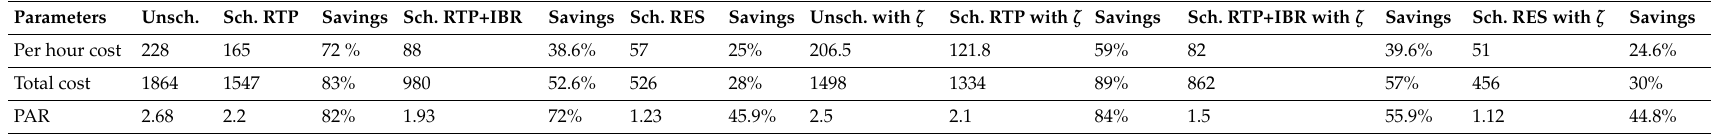
Table 8. Comparison of results without and with effect of control